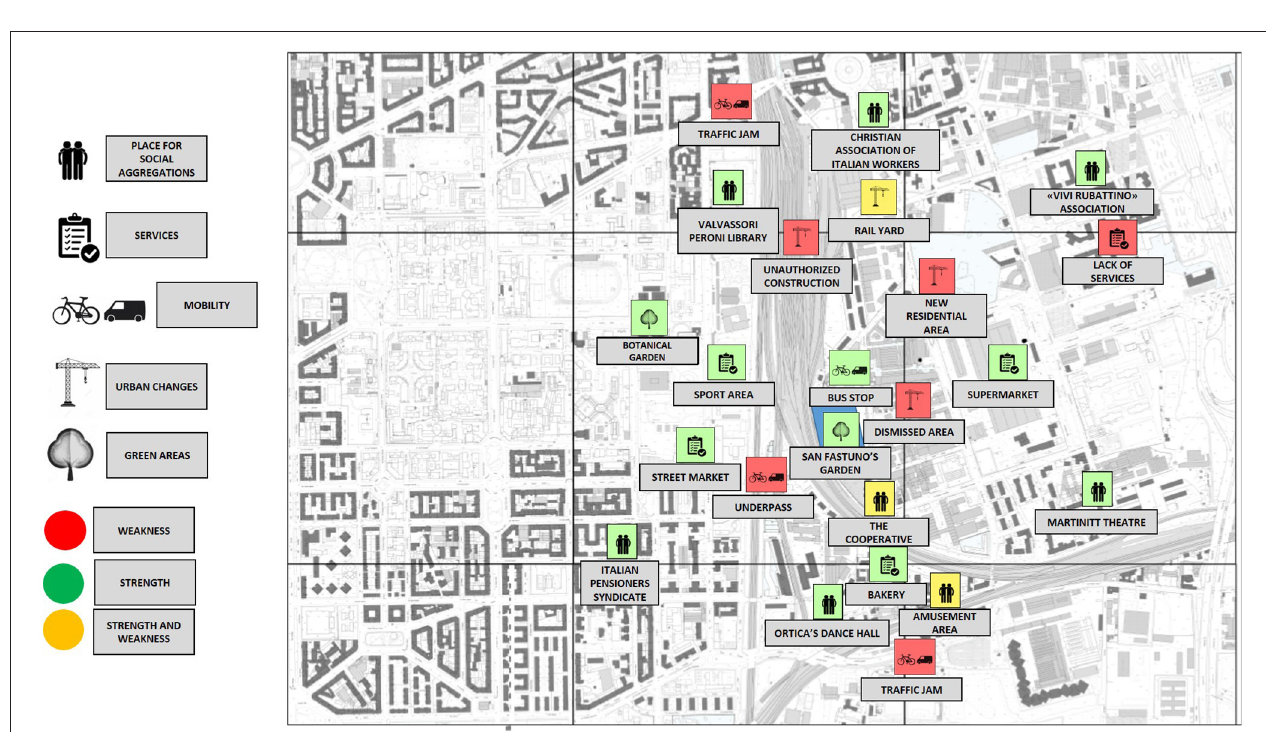
FIGURE 2 | A map resulting from the older people actively involved in local associations. The CG position is marked in blue.